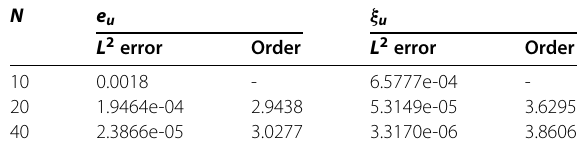
Table 4 The numerical results of the LDG method with the piecewise P 2 space at the final time T = 0.5